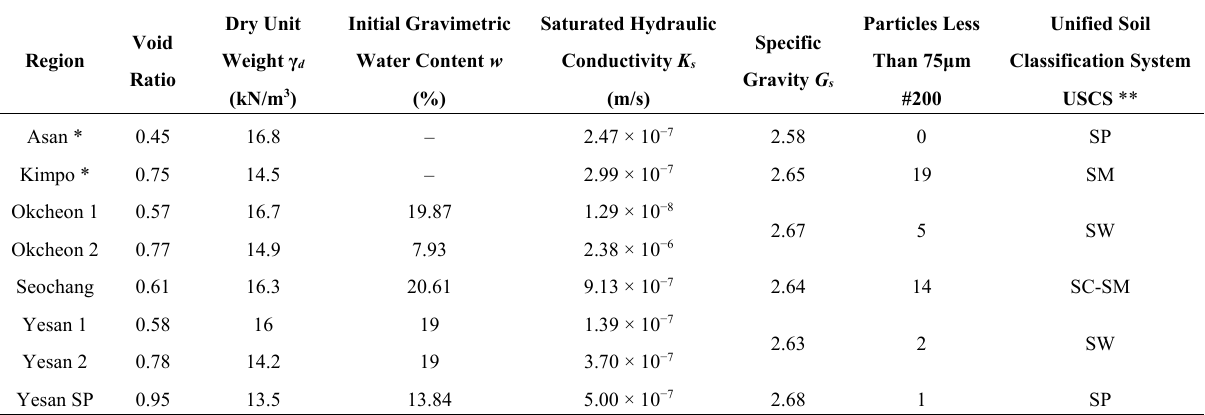
Table 1. Geotechnical